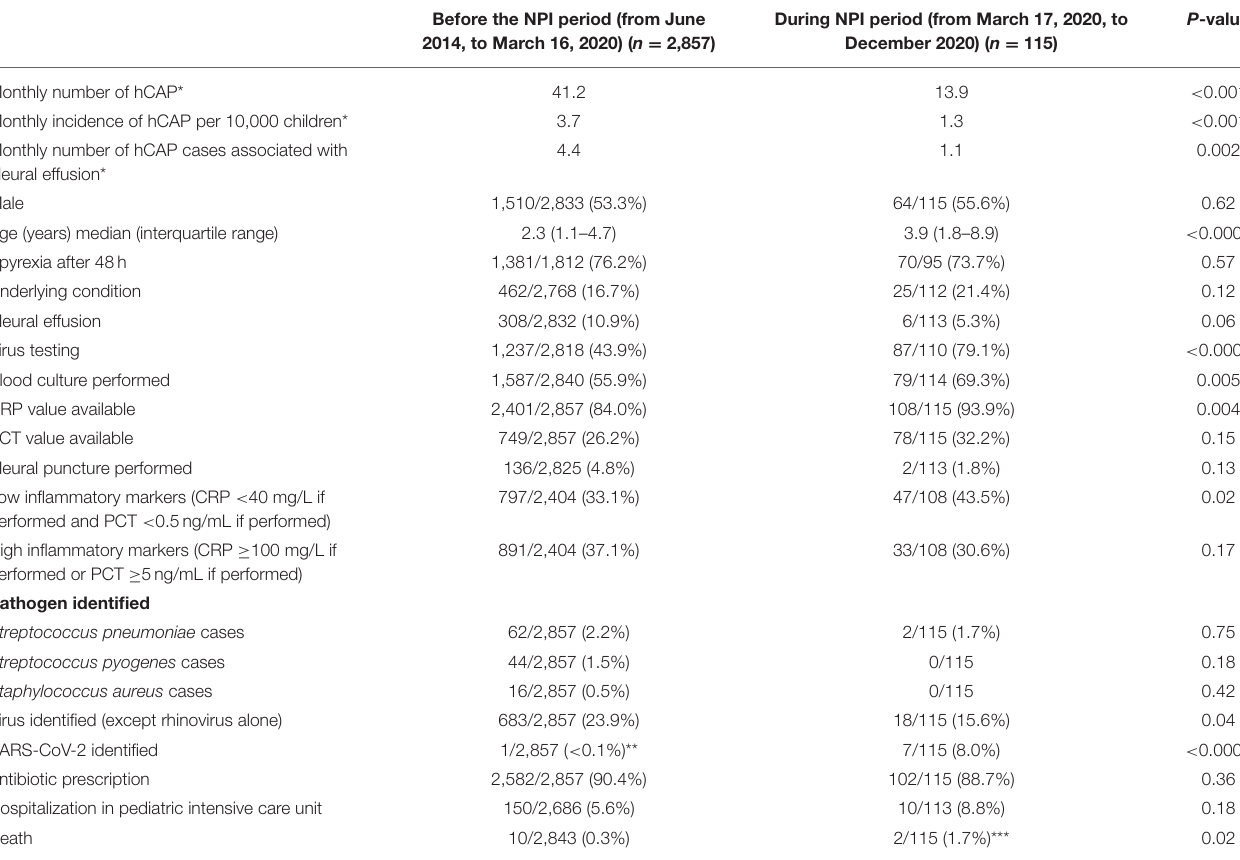
* Estimated with segmented linear regression model. ** The patient was positive for SARS-CoV-2 on March 10, 2020. *** The two patients had severe encephalopathy. CRP, C-reactive protein; hCAP, hospitalized community-acquired pneumonia; PCT, procalcitonin; RSV, respiratory syncytial